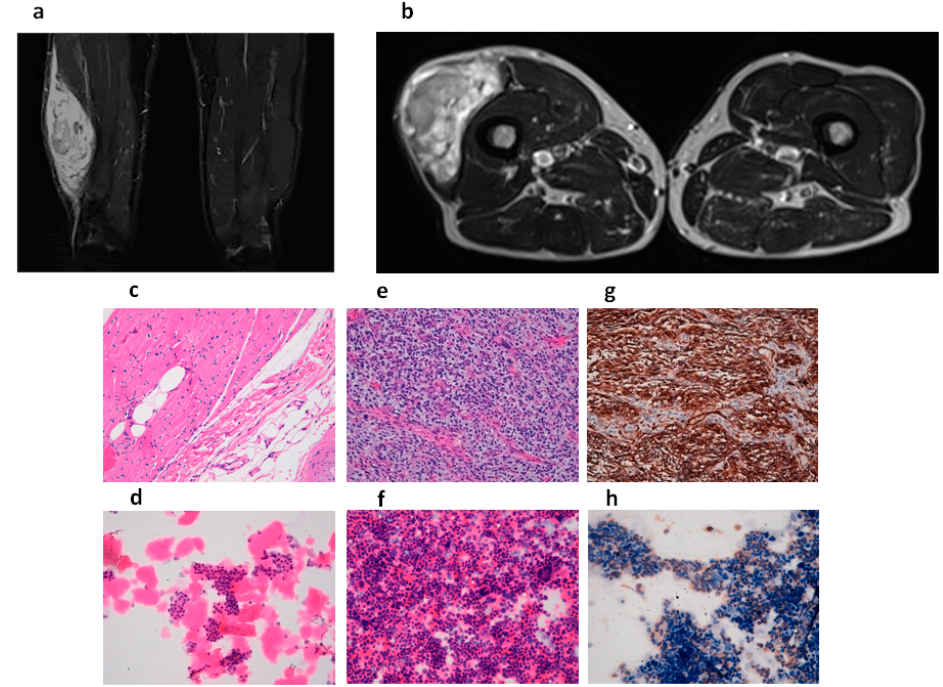
Figure 2. ( a ) Coronal post-contrast MRI image showing the presence of a large solid mass in the vastus lateralis of the right quadriceps femoris muscle (longitudinal diameter 20 cm). Absence of focal abnormalities in the remaining muscle–tendon structures of the thigh bilaterally; ( b ) Axial MRI image of the lesion (transverse diameter 53 mm × 88 mm) located in the middle–distal third of the quadriceps femoris muscle; ( c ) H&E staining of the surgical specimen showing the tumor-infiltrated muscle (20 × ). Margins were negative (R0 resection); ( d ) H&E staining of cytospun healthy cells from the patient-derived UPS primary culture (20 × ); ( e ) H&E staining of the surgical specimen showing undifferentiated pleomorphic sarcoma cells (light blue stroma) (20 × ); ( f ) H&E staining of cytospun UPS primary culture showing undifferentiated pleomorphic sarcoma cells (light blue stroma) (20 × ); ( g ) Immunohistochemical expression of CD34 in the tumor specimen showing undifferentiated pleomorphic sarcoma cells (brown cytoplasmic staining); ( h ) Immunohistochemical expression of CD34 in the cytospun UPS primary culture showing undifferentiated pleomorphic sarcoma cells (brown cytoplasmic staining) and cell nuclei stained with hematoxylin (blue spots).